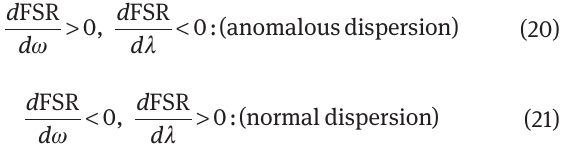
[45–47]. Such an analytical expression provides an accu- rate calculation of the mode frequencies and field distri- bution for WGM resonators, and it has already been used to calculate geometric dispersion. However, this method